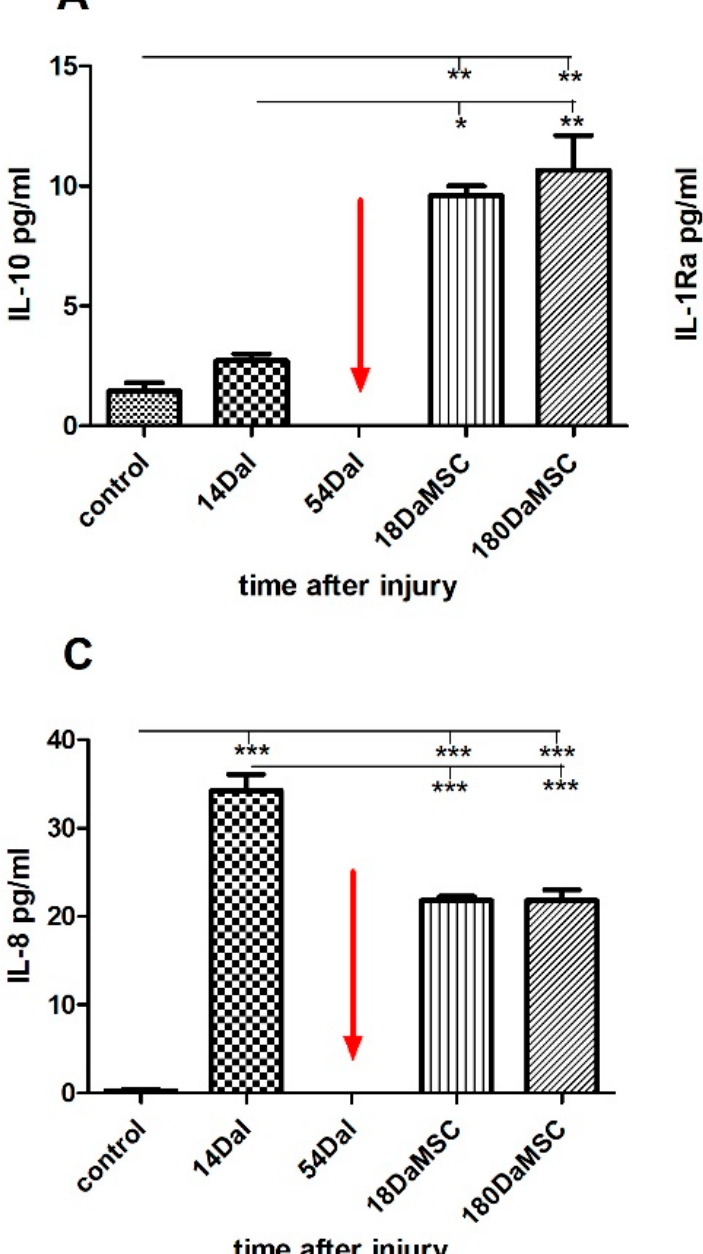
Figure 5. Influence of autologous BM-MSCs treatment on cytokine concentrations in the serum of an SCI patient. Levels of the cytokines IL-10 and IL-1Ra were significantly increased after BM-MSCs application at 18 DaMSC in comparison with their levels before the treatment ( A , B ). The level of IL-8 was significantly reduced at 18 DaMSC and 180 DaMSC due to BM-MSCs administration when compared with its level at 14 DaI before the treatment ( C ). The red arrow indicates the administration time of autologous BM-MSCs. Data are shown as the mean ± SD, * p < 0.05, ** p < 0.01, *** p < 0.001. DaI—Days after Injury, DaMSC—Days after BM-MSCs